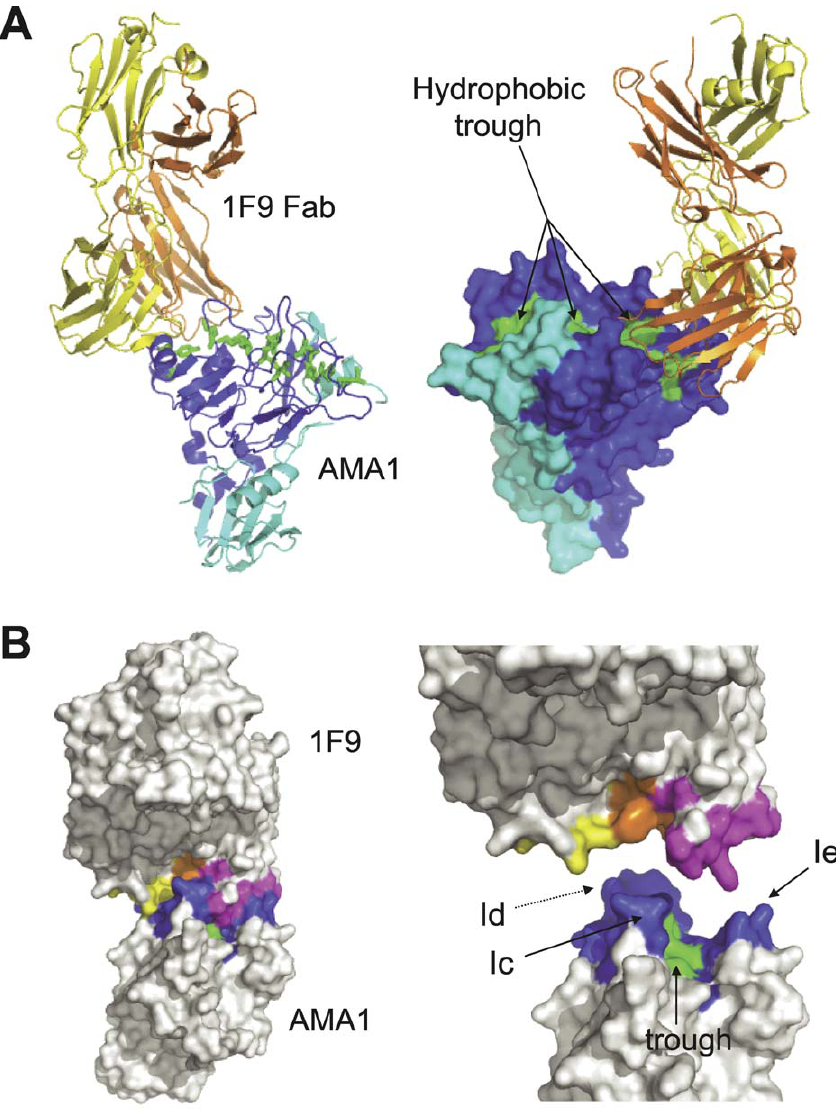
Figure 1. Structure of AMA1 in Complex with 1F9 Fab (A) Alternate views of AMA1 in complex with 1F9 Fab. Backbone trace of 1F9 Fab with the heavy chain coloured orange and the light chain coloured yellow. Backbone trace of AMA1 (left) or surface view (right) with domain I coloured dark blue and domain II coloured light blue. The AMA1 hydrophobic trough is coloured green. This figure and other figures depicting the structure were generated using PyMOL [56]. (B) Surface representation of the 1F9 Fab bound to AMA1. View of the complex (left), or 1F9 and AMA1 separated (right). Light chain residues that contact AMA1 (within 4 A˚) are coloured yellow. Heavy chain residues that contact AMA1 are coloured orange (residues from the CDR loops) or pink (framework residues). AMA1 residues within 4 A˚ of 1F9 are coloured dark blue, with the hydrophobic trough residues contacting 1F9 coloured green. AMA1 loops Ic, Id, and Ie are indicated.